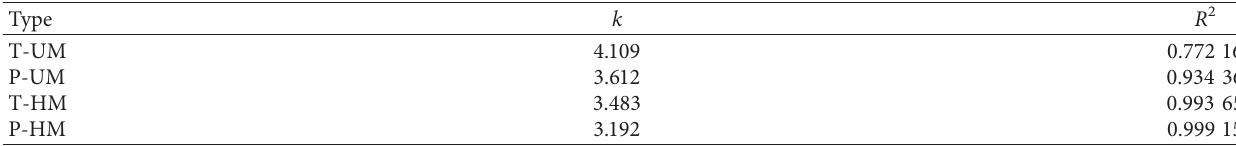
Table 5: Fitting results by using the Mohr–Coulomb criterion.